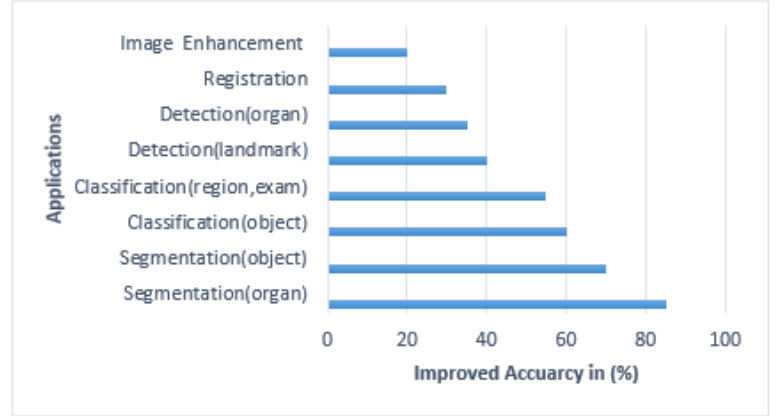
Figure 5. Accuracy vs. deep learning applications.